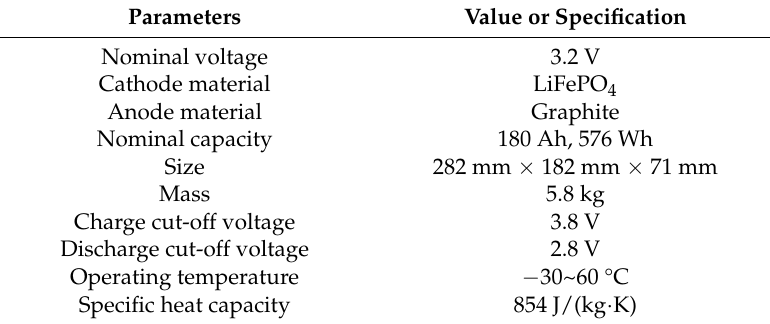
Table 1. Basic parameters of the cell.